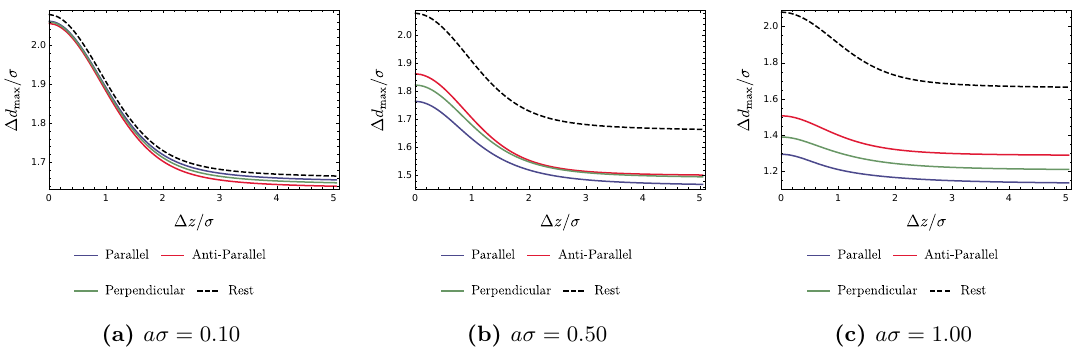
Figure 12. The separation, ∆ d max , between two detectors when entanglement harvesting does not occur is plotted as a function of the distance between detectors and boundary for the three acceleration scenarios. Here, we have set Ω σ = 0 . 10 and aσ = { 0 . 10 , 0 . 50 , 1 . 00 } in the left-to-right order, and the dashed curve denotes the case two rest detectors.